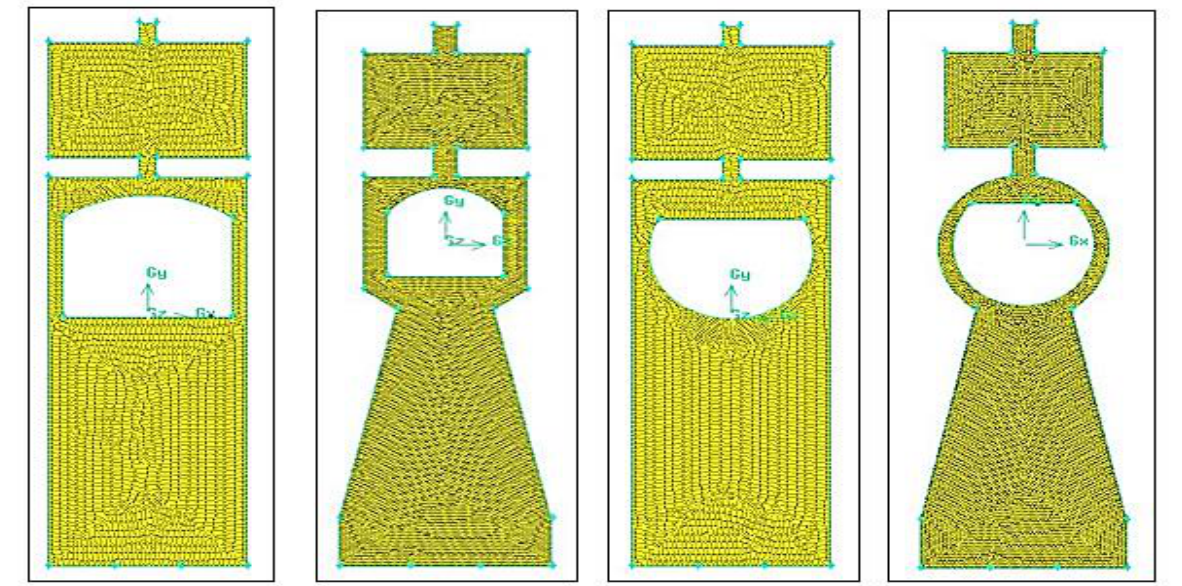
Figure 3. Mesh generation in the computational domain for the four different modified